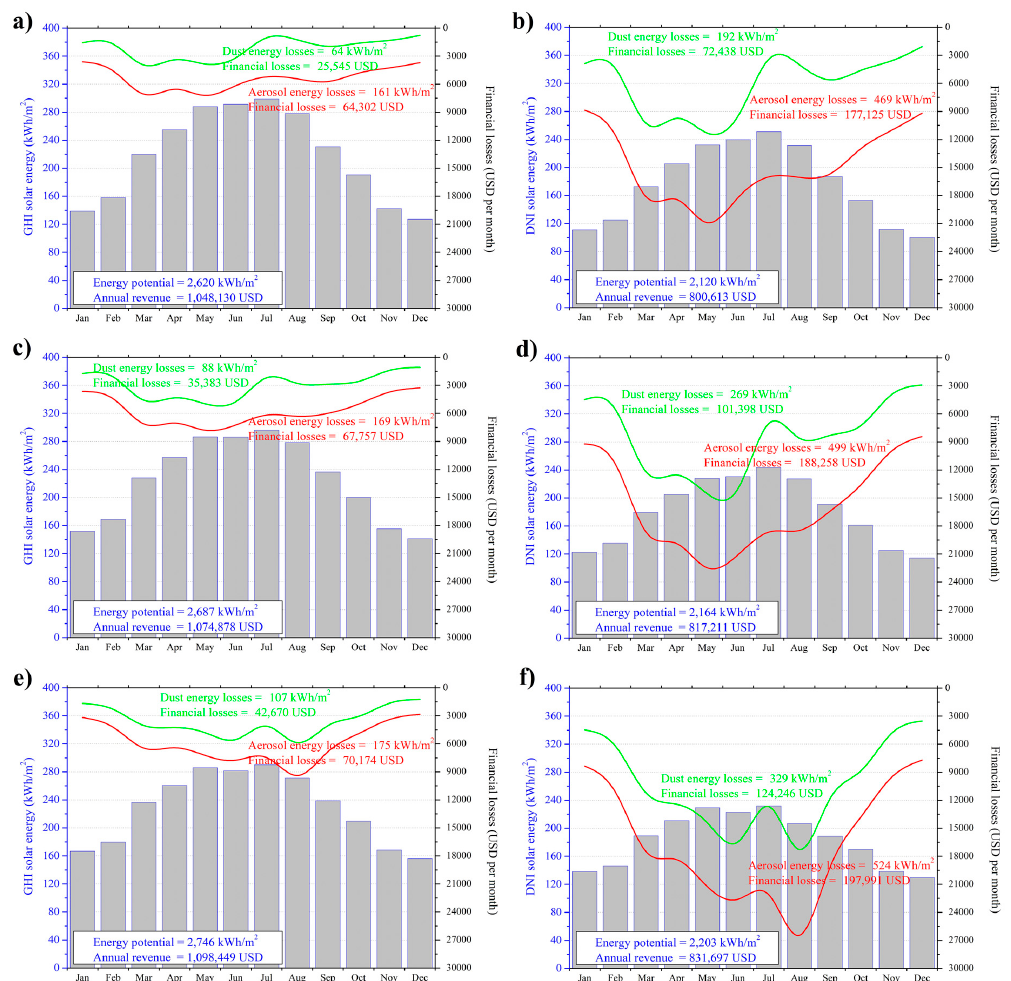
Figure 10. Financial analysis of the aerosol and dust impacts on the produced solar energy from PV ( a , c , e ) and CSP ( b , d , f ) installations with nominal power of 10MW in the regions of CAI ( a , b ), ASY ( c , d ) and ASW ( e , f ). The impact was quantified in terms of monthly mean and total financial losses and solar energy potential.